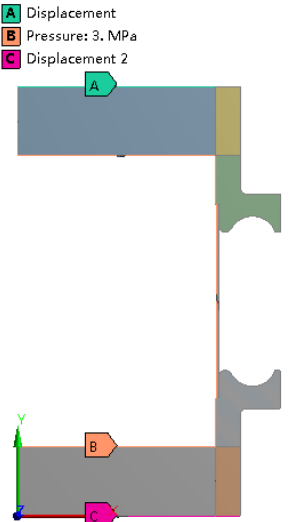
Figure 6. Constraint setting for the